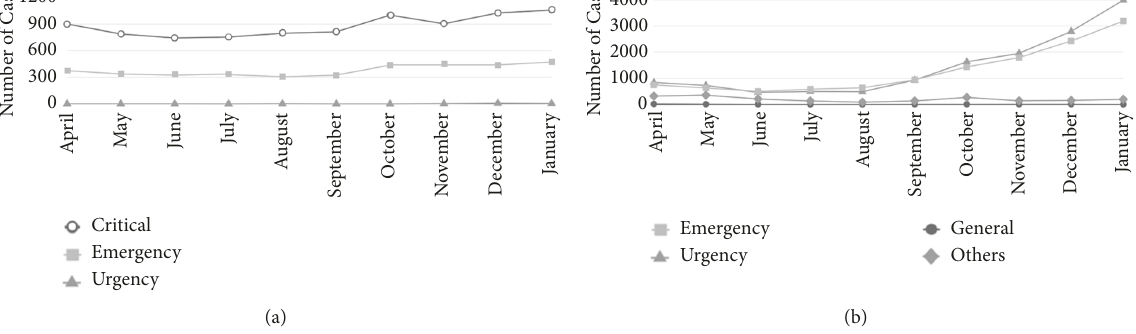
Figure 1: The trend of ED visits categorized by urgency levels in authorized patients (a) and unauthorized patients (b) from April 2017 to October 2017. Table 6: Univariate and multivariate analysis of the association between health insurance status and approval status. Health insurance status